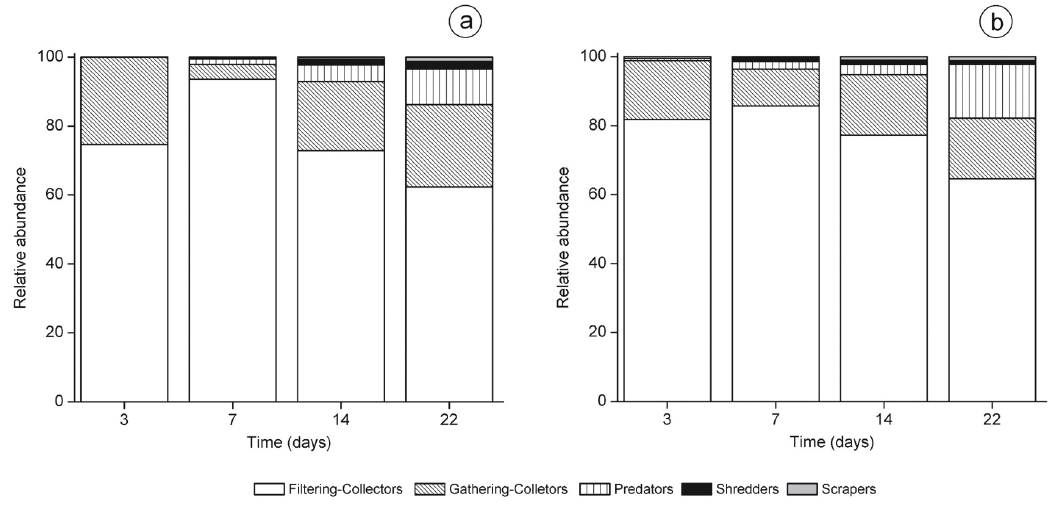
Figure 2. Temporal variations in invertebrate density individuals per gram of ash free dry mass [AFDM]; mean ± SE) on leaves of tree species in a subtropical stream.